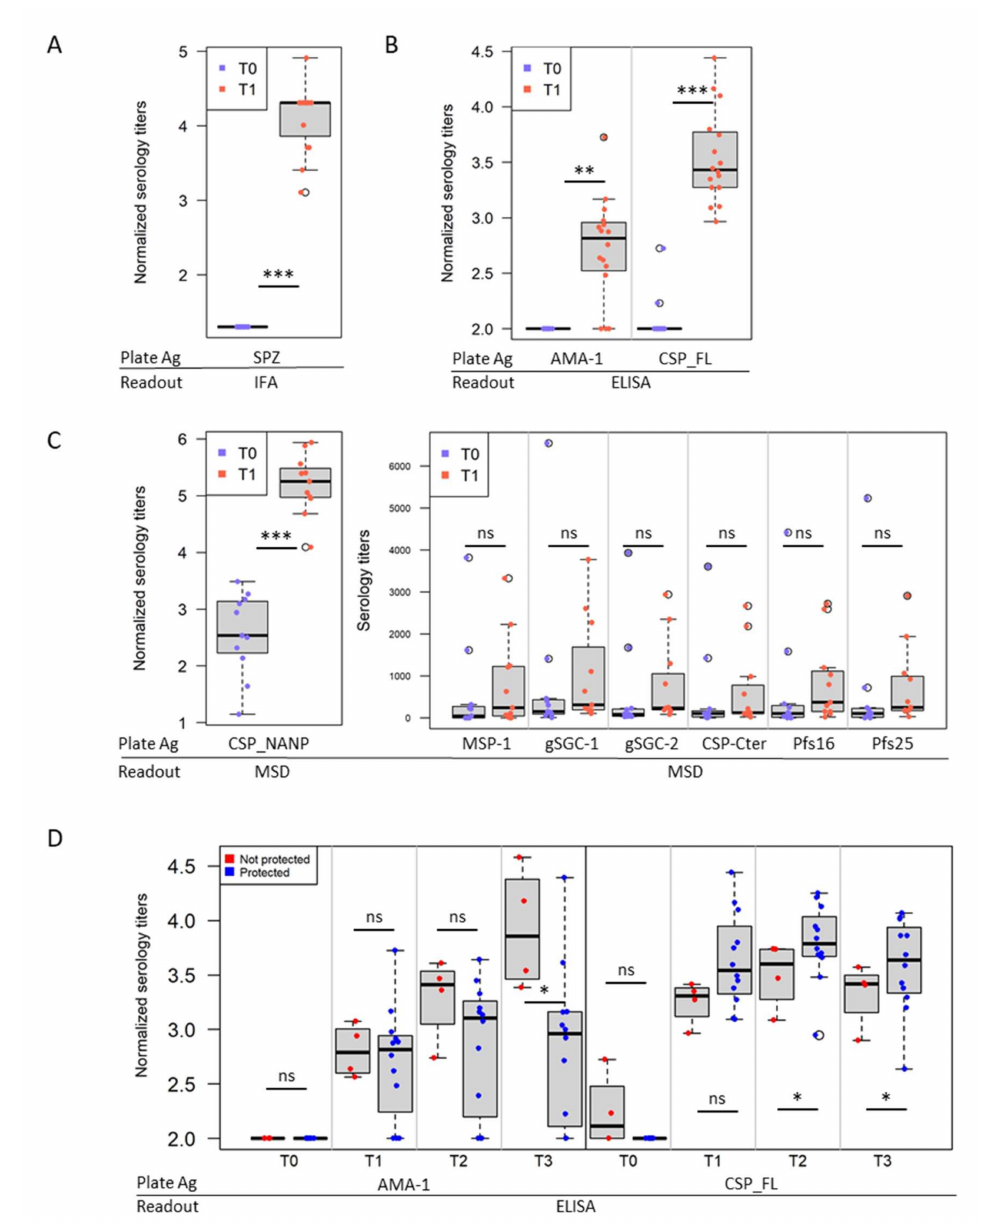
nization (Figure 3C). Stratifying the responses to AMA-1 and CSP by protection status demonstrated that antibody levels to AMA-1 were lower in protected individuals after CHMI (T3, p = 0.021, q = 0.15), while the antibody titers to CSP were higher in protected individuals prior to and after CHMI (T2, p = 0.042, q = 0.15; T3, p = 0.037, q = 0.15).